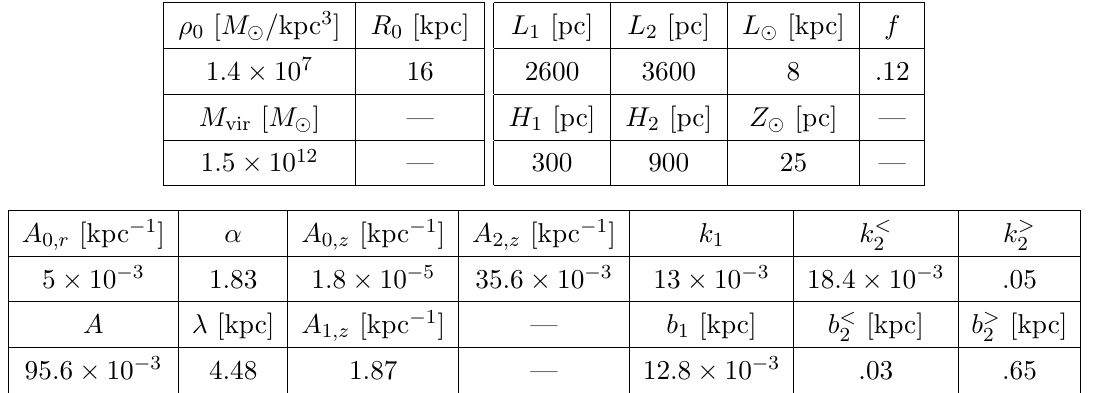
Table 1 . Astrophysical parameters describing the Milky Way, which we use in the calculation of collision rates. The table on the top-left describes the dark matter halo using an NFW pro(cid:12)le using data from [55]; the top-right table describes the distribution of stars using [56]; and the table along the bottom gives parameters describing the distribution of neutron stars using